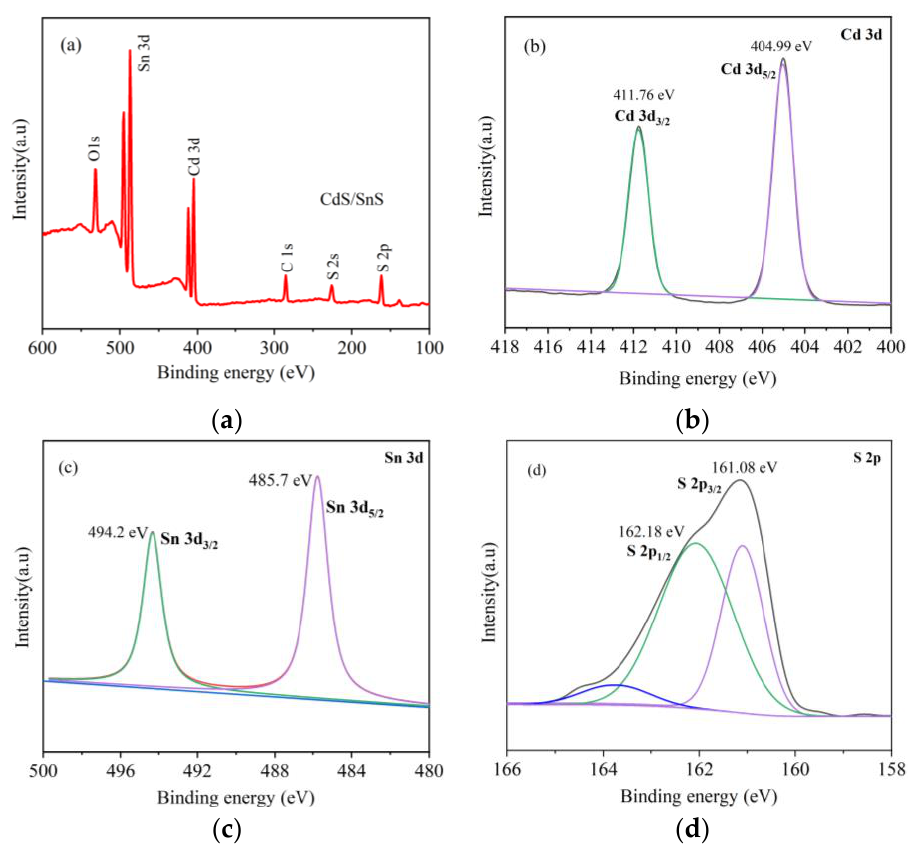
Figure 5. XPS spectra of CdS/SnS: ( a ) survey spectrum of CdS/SnS, ( b ) Cd 3d, ( c ) Sn 3d and ( d ) S 2p.